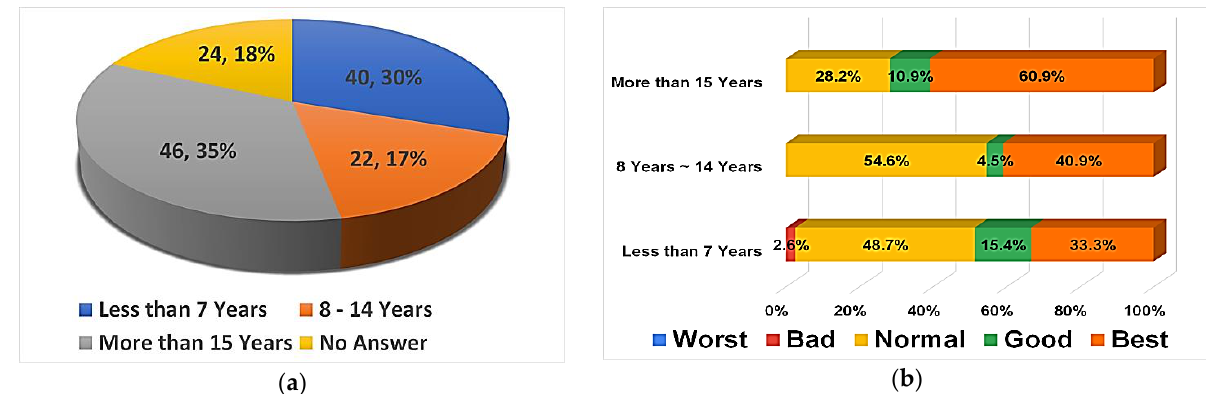
Figure 5. ( a ) Respondents composition based on their experience of GPS plotters; ( b ) their preference on applying standard icons on the menu.